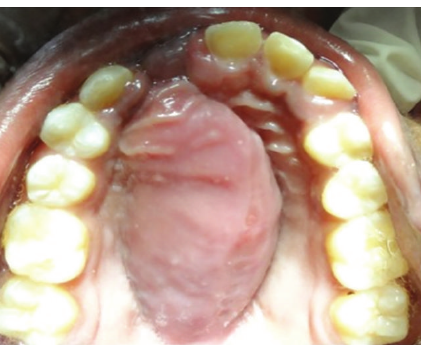
Figure 1: Intraoral preoperative photograph showing palatal swelling.